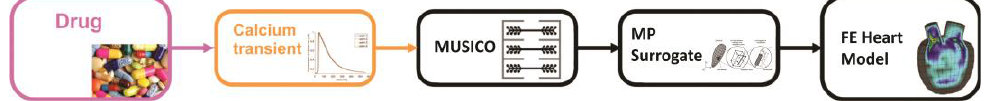
Figure 3. Scenario 1: Drug action via modulation of calcium transient. Adopted from ref. [16].